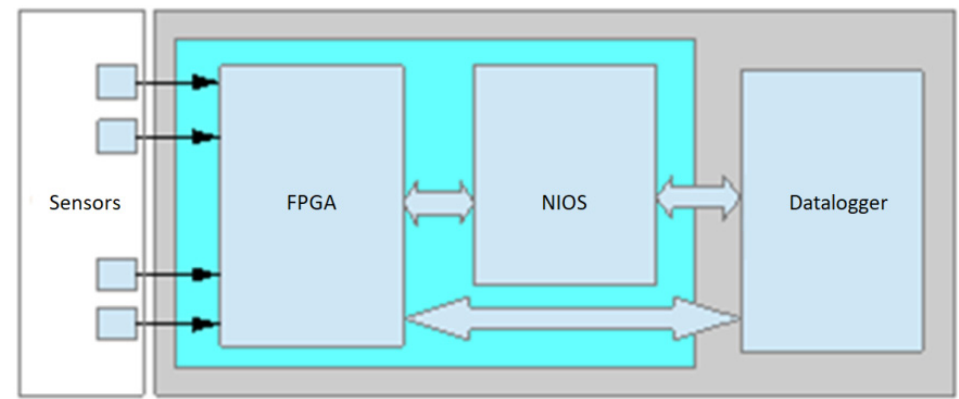
Figure 9. Block diagram of the WIM recorder.